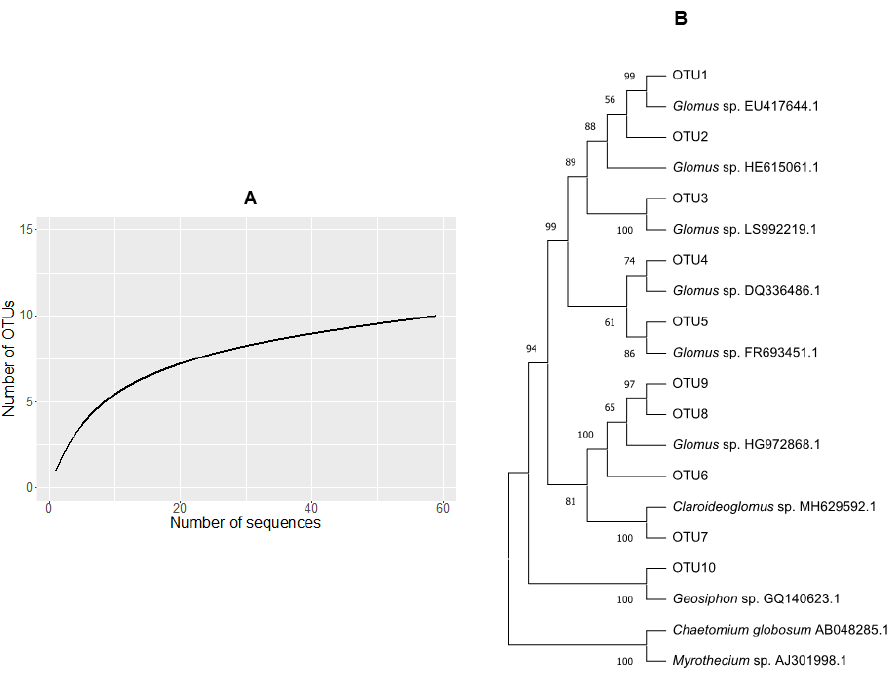
Figure 3. AMF OTUs detected in the soil of coastal sand dune vegetation. The rarefaction curve was plotted from the SSU sequences of Glomeromycota amplified from soil collected from the study sites ( A ). Phytotaxonomic analyses of representative AMF OTUs and their closest sequence similarity from the MaarjAM and NCBI databases were constructed from the SSU sequences of AMF spores present in the soil collected from the study site (1000 bootstrap) ( B ). GenBank accessions are placed behind AMF reference species reported in the